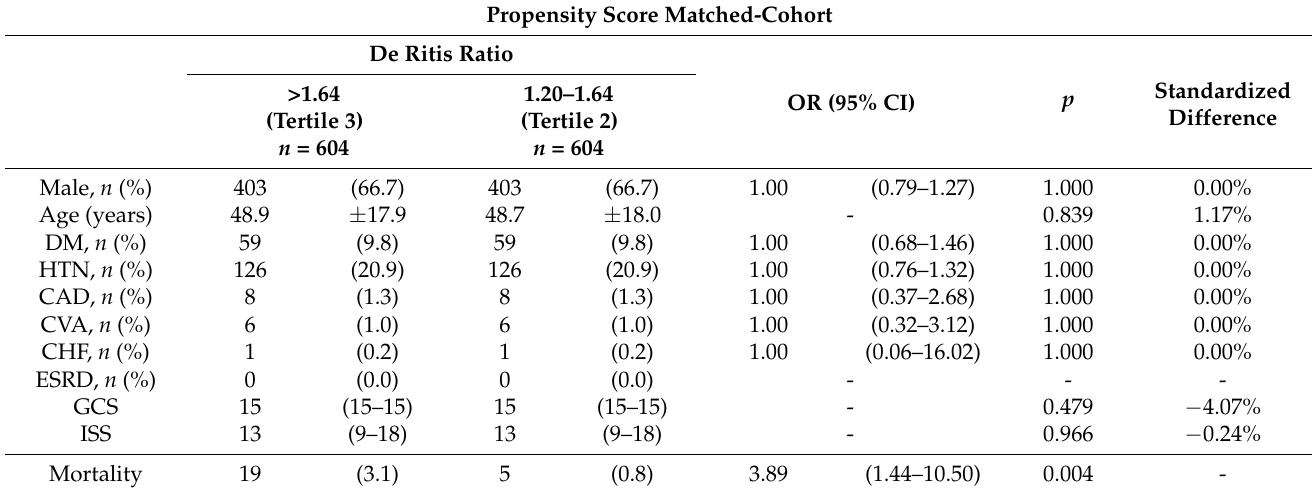
Table 2. Propensity score matched-cohort of patients in the tertile 3 vs. tertile 2 groups.